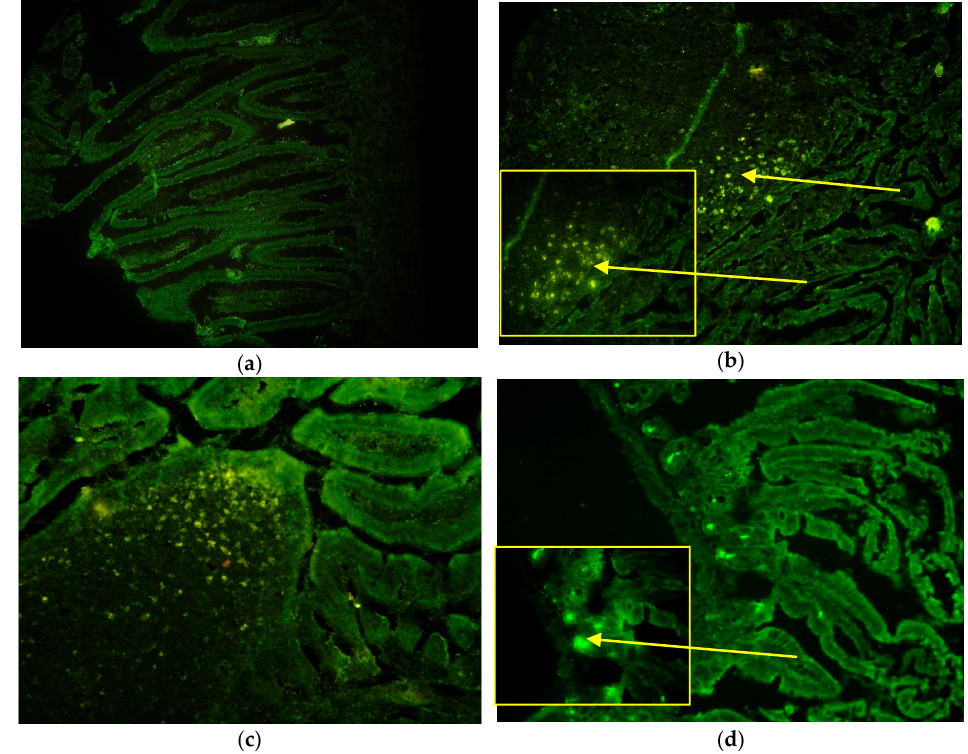
Figure 3. Localization of eGFP-CVB3 in the small intestines of infected mice. The fluorescent signal of enhanced green fluorescent protein (eGFP) can be seen as bright yellowish green fluorescent. The bright yellow arrows show the positive signals of the eGFP positive infected areas. ( a ) absence of fluorescence at 4h in the mock infected control mice, 20×; ( b ) At 6 h p.i. fluorescence can be seen in the sub-epithelial dome area of the PP and the FAE area after oral infection 20× with zoomed in 40×; ( c ) At 12 h p.i. fluorescence can be seen in the dome area of the PP and the FAE area after i.p. infection 20×; ( d ) at 8 h p.i. eGFP can be seen in the base of the villi or crypts of Lieberkuhn 20× and zoomed in at 40×. The yellow arrows show positive signals.